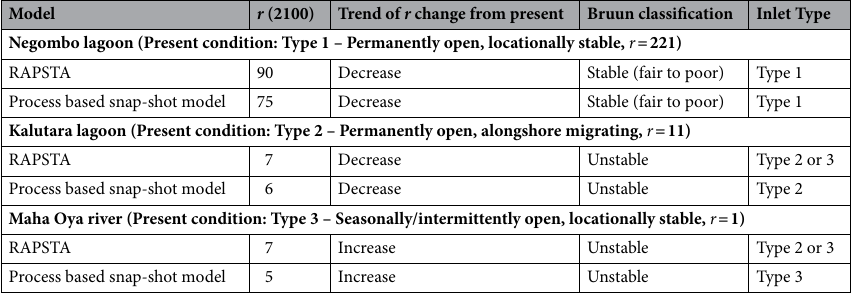
Table 3. Comparison of end-century, RCP 8.5 median r values and inlet Type projected by the reduced complexity model RAPSTA with the projections obtained from the process based snap-shot approach of Duong et al. 13 for the 3 STIs. The present conditions are from Duong et al. 13